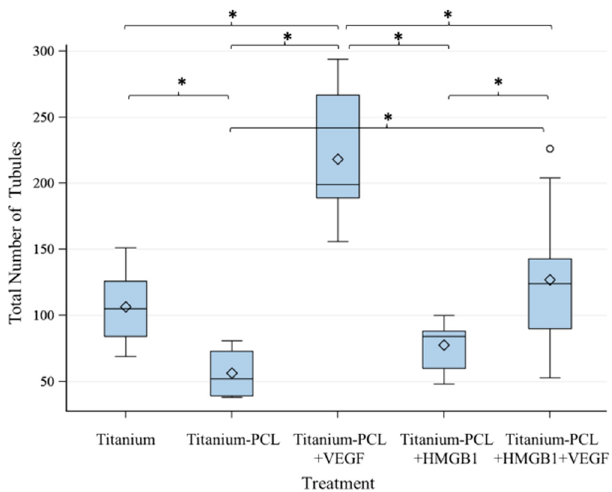
Figure 5. Number of Tubules built by investigated implants. VEGF-functionalized titanium-PCL implants built significantly more tubules than all of the other implants. VEGF + HMGB1-functionalized titanium-PCL implants showed significantly more tubules than titanium-PCL implants and HMGB1 functionalized titanium-PCL implants. Pure titanium implants showed better results than titanium-PCL implants. F -test from the analysis of variance followed by pairwise multiple means comparisons with the Least Significant Difference test were used ( p ≤ 0.05).